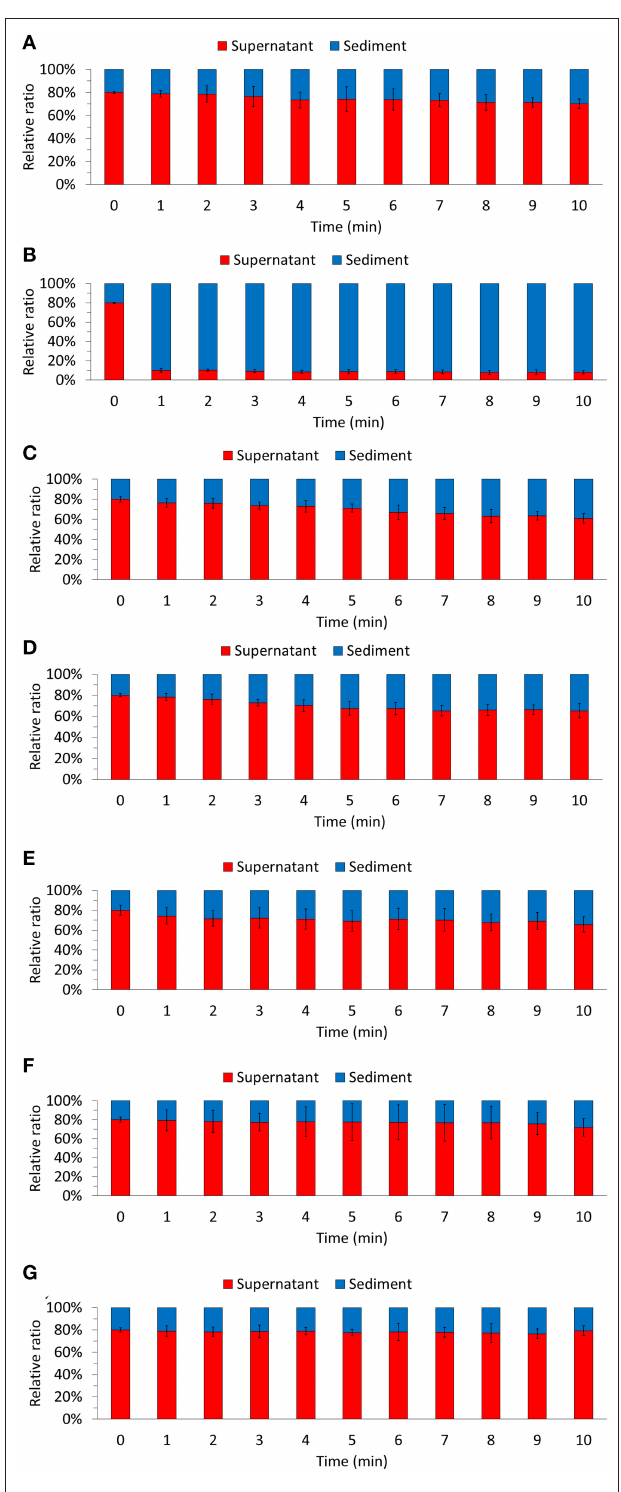
FIGURE 2 | Biomass sedimentation ability was evaluated for each of the culture condition. N (A) , MC (B) , M. jejuensis (C) , CC (D) , C. flocculans (E) , EC (F) , and E. coli (G) . MC, M. jejuensis and C. sorokiniana ; CC, C. flocculans , and C. sorokiniana ; EC, E. coli and C. sorokiniana ; N, C. sorokiniana only, control group. Marked characteristics are annotated in Supplementary Figure 1 . We herein expressed the ratio of biomass present, which we defined as